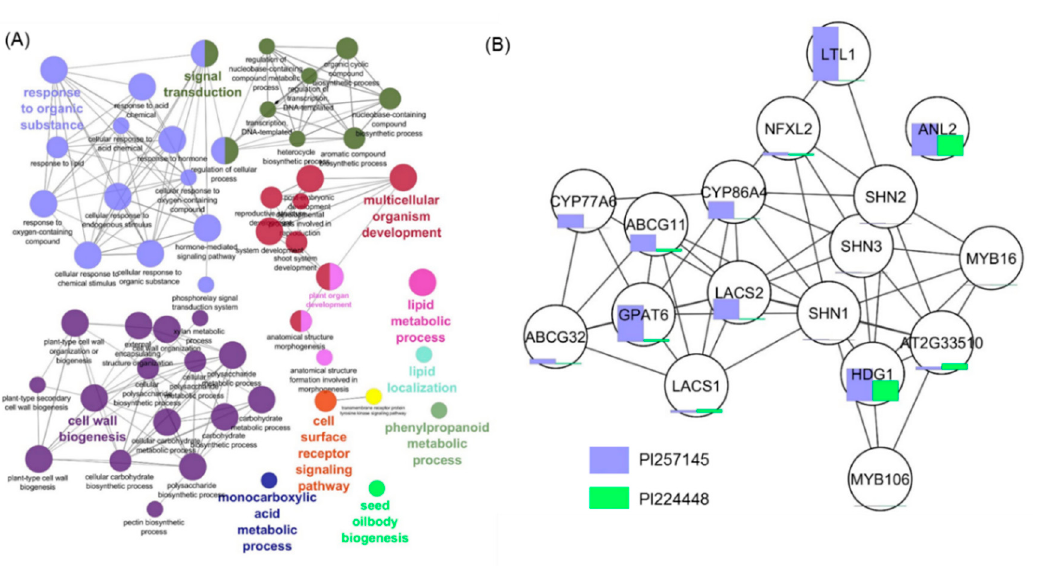
Figure 6. ( A ) Functional network analysis of upregulated genes in PI 257145 showing the functionally grouped terms with nodes linked based on their kappa score level ( ≥ 0.3), where only the label of the most significant term per group is shown. The node size represents the enrichment significance of the term. ( B ) Network analysis of genes involved in cutin biosynthesis in Capsicum chinense . Bar chart associated with the nodes shows the expression value fragments per kilobase of transcripts per million (FPKM) between PI 257145 and PI 224448.